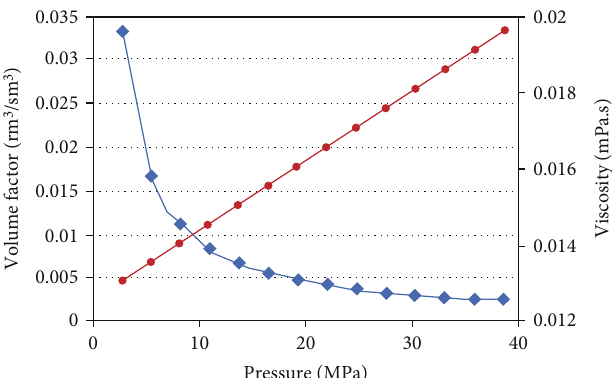
Figure 8: Volume factor and viscosity changing with pressure for free